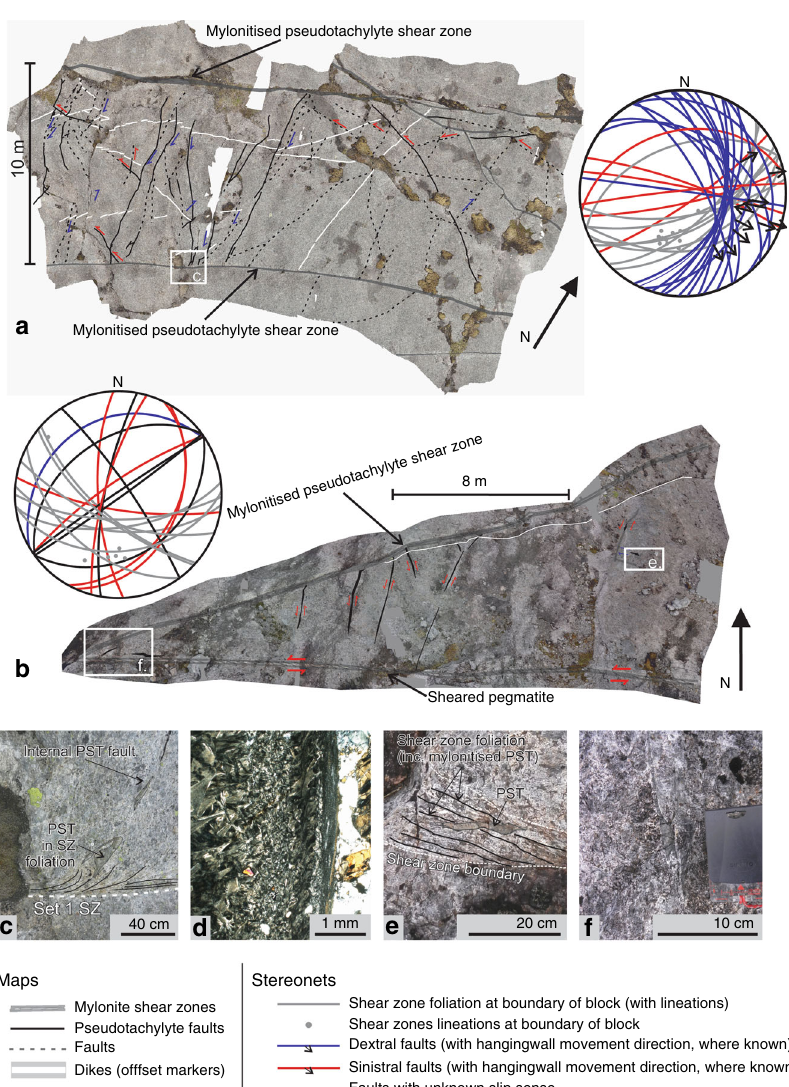
Shear zone foliation at boundary of block (with lineations)Mylonite shear Sinistral faults (with hangingwall movement direction, where known) Faults with unknown slip sense Fig. 3 Type-2 pseudotachylyte faults within shear zone-bounded blocks. a map of pseudotachylyte fault network developed between two SE-dipping Set 1 shear zones [68.0557 °N 13.3744°E] and stereonet of fault and shear zone orientations for the region (separated versions of the photo-map and sketch maps for parts a and b are available in Supplementary Fig. 4); b map of pseudotachylyte fault network developed between a SE-dipping Set 1 shear zone and a SW-dipping Set 2 shear zone [68.0552°N 13.3678°E] and stereonet of shear zone and pseudotachylyte orientations; c southern boundary shear zone of system in 3a shows pseudotachylyte faults dragged into shear zone foliation; d micrograph of type-2 pseudotachylyte vein showing transition from radiating microlites to fi ne-grained and viscously sheared margin of pseudotachylyte vein (cross-polarised light); e detail of the intersection between the two shear zones, including scattered pseudotachylytes which cross from the undeformed internal region into the shear zones and are partially transposed along the foliation; f sinistral stepover jog developed in type-2